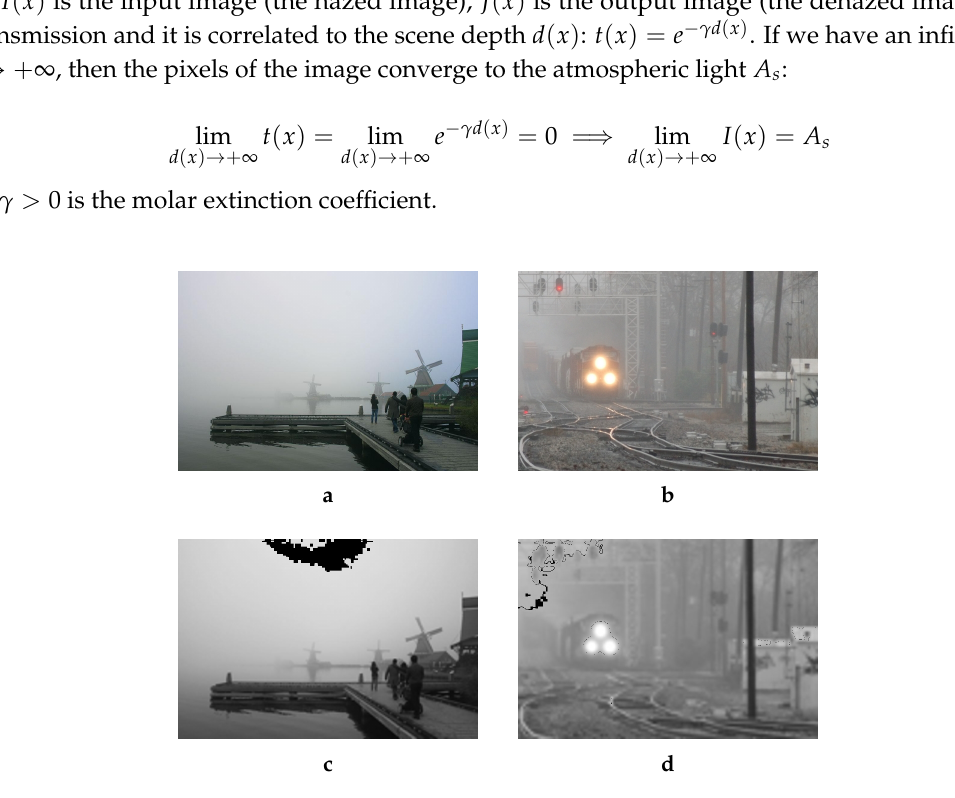
Figure 1. This Figure shows two examples of hazed images (first row) and black pixels showing the location of the estimated A s (second row). With scale = 0.2 and win = 10. ( a ): Hazy image-1. ( b ): Hazy image-2. ( c ): The location of the color of the haze in black pixels for the image ( a ). ( d ): The location of the color of the haze in black pixels for the image ( b